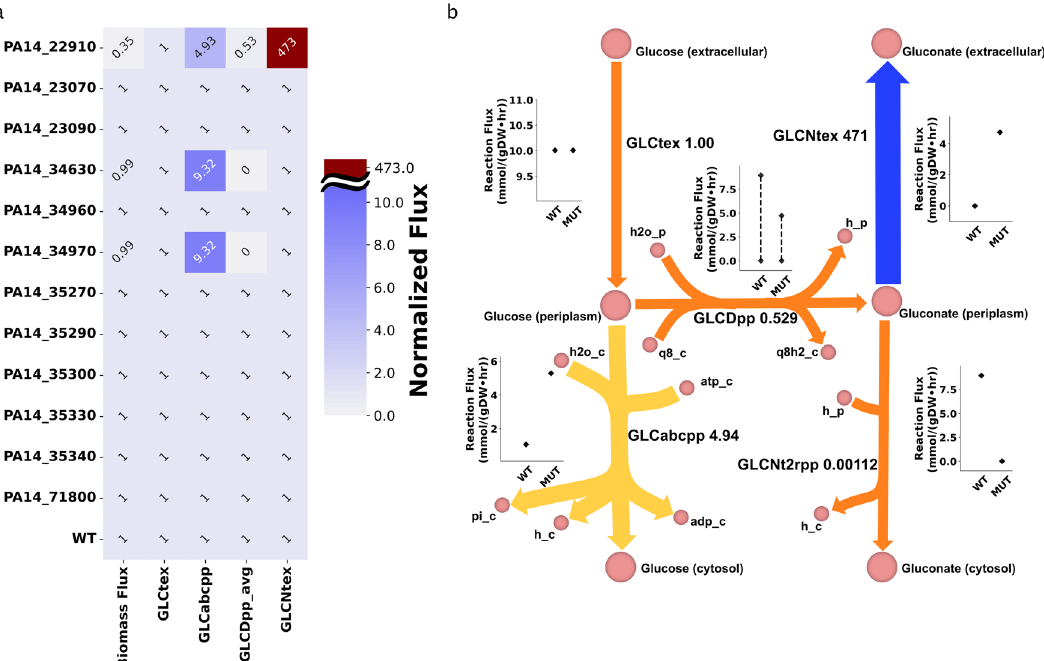
Fig. 4 Our model can accurately predict gluconate production in the mutants of the genes regulated by RpoN. Twelve genes regulated by RpoN were in silico knocked out in this study in order to recapitulate the results of experimental study 32 . a FBA simulations were able to accurately predict that only edd mutant (PA14_22910) produces considerable amount of gluconate as shown by higher fl ux in reaction GLCNtex (demonstrated in Fig. 4b) compared to the wildtype. Furthermore, the decrease in the growth rate of the mutant was also recapitulated in this study (left). For calculations, all fl ux values were increased by 0.01 for normalization purpose. The fl uxes of the reactions catalyzed by glucose dehydrogenase (GLCDpp and GLCDpp_q9) have been averaged (column GLCDpp_avg). Then, mutant reaction fl uxes were divided by respective wildtype reaction fl uxes. b To further characterize the edd mutant, FVA simulations were carried out in order to examine the fl ux range of desired reactions in both wildtype and mutant. Gluconate excretion is required by the mutant for optimal growth in the given condition. Furthermore, the glucose fl ux in the mutant is divided between glucose transport and glucose dehydrogenase reactions whereas in the wildtype, majority of the fl ux is channeled towards the Entner-Doudoroff pathway through glucose dehydrogenase reaction (Supplementary Fig. 3). The values (after the reaction names) are derived by dividing the average reaction fl uxes of the edd mutant by those of the wildtype. To avoid division by zeroes, all the simulation values were fi rst increased by 0.01. Absolute values are reported in the fi gure. In the fi gures: Biomass biomass reaction, GLCtex glucose transport (from extracellular to periplasm), GLCabcpp glucose transport (from periplasm to cytosol), GLCDpp/GLCDpp_avg glucose dehydrogenase, GLCNt2rpp gluconate transport (from periplasm to cytosol).